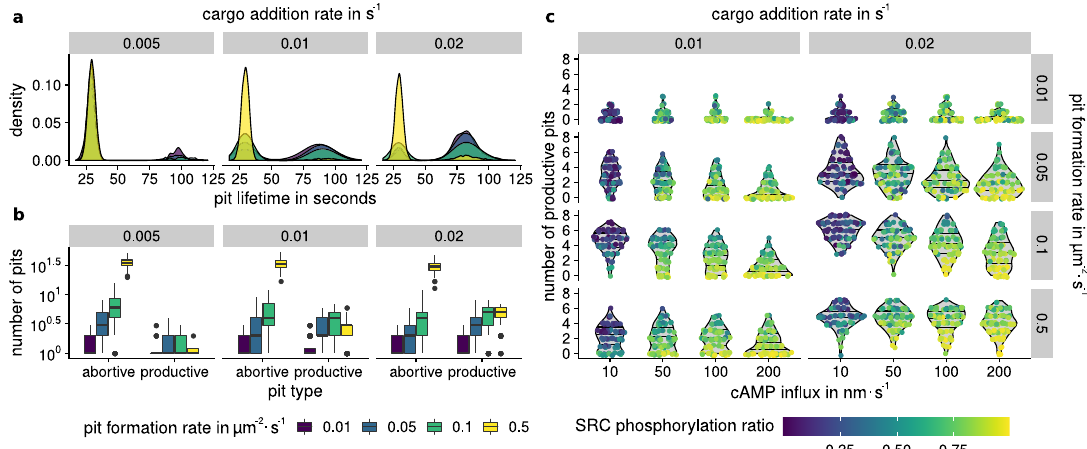
Fig. 5 Distribution of abortive and productive endocytotic pits. a Lifetime of endocytotic pits across all simulations at varying cargo addition rates. The fi rst peak indicates abortive pits that did not enter the maturation phase, the second peak indicates pits that matured to vesicles. b The number of abortive and productive pits after fi ve minutes. High cargo addition rate leads to high number of productive pits. After a substantial amount of AQP2 molecules are transferred to vesicles, no new productive pits are able to form. The central line represents the median, lower and upper box boundaries correspond to the fi rst and third quartiles (the 25th and 75th percentiles). The whiskers extend to the largest/smallest value, no further than 1.5 time the interquartile range. Data beyond the end of the whiskers (outliers) are plotted individually. c Number of productive pits at varying parameters, colored by average SRC phosphorylation ratio. Low cAMP in fl ux leads to higher number of productive pits, given a suf fi cient pit formation rate. Horizontal lines are drawn in the background density estimates at 25%, 50%, and 75% quantiles. High SRC phosphorylation ratio results in fewer productive pits. Abbreviation: non-receptor tyrosine kinase Src